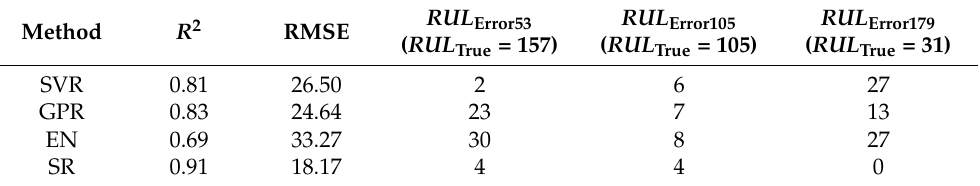
Table 3. Comparison of RUL prediction results of GPR, SVR, EN, and SR ( RUL Error =| RUL prediction – RUL True |).